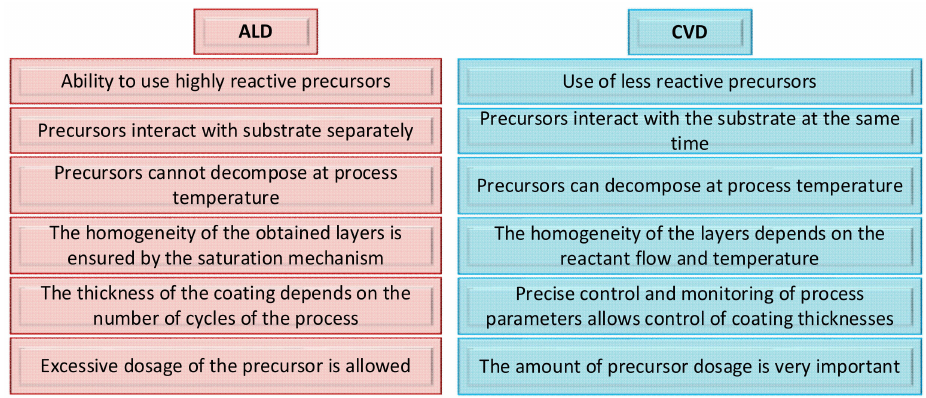
Figure 8. Comparison of ALD and CVD processes